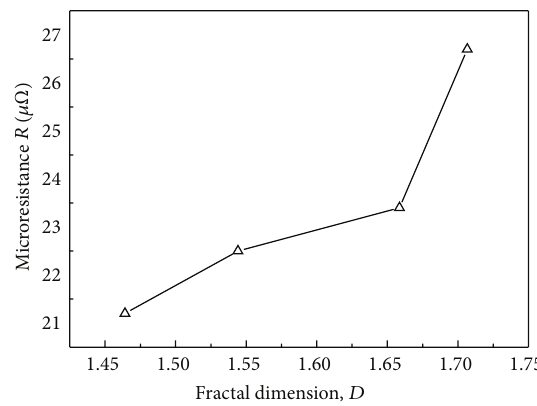
Figure8:Microresistanceversusfractaldimensionforporousmetal powder